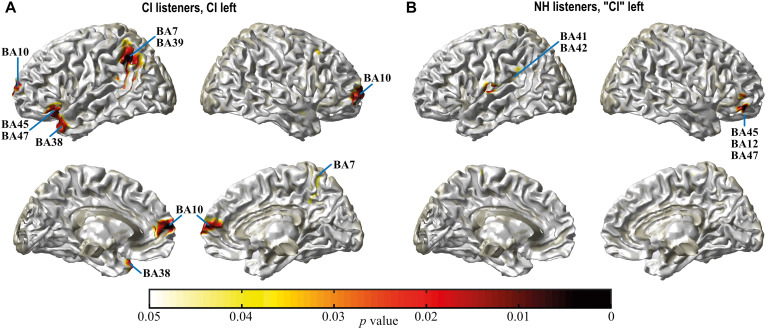
Spatial spread of monaural vs. binaural activation in CI listeners at T4 (A) and in NH (B) during the N1 interval. Only differences in regions bordering the surface or the midline of the cortex are visible in this illustration. For a complete list of areas with differential activation (see Table 6). Differences are more widespread in CI listeners compared to NH. Whereas in NH differential activation located to primary and secondary auditory cortex (BA41, 42), it pertained to auditory association cortex related to speech processing (BA21, 38, 39) and a region related with these areas (BA7) in the bimodal listeners. Darkening of the color scale indicates decreasing p values or higher significance.